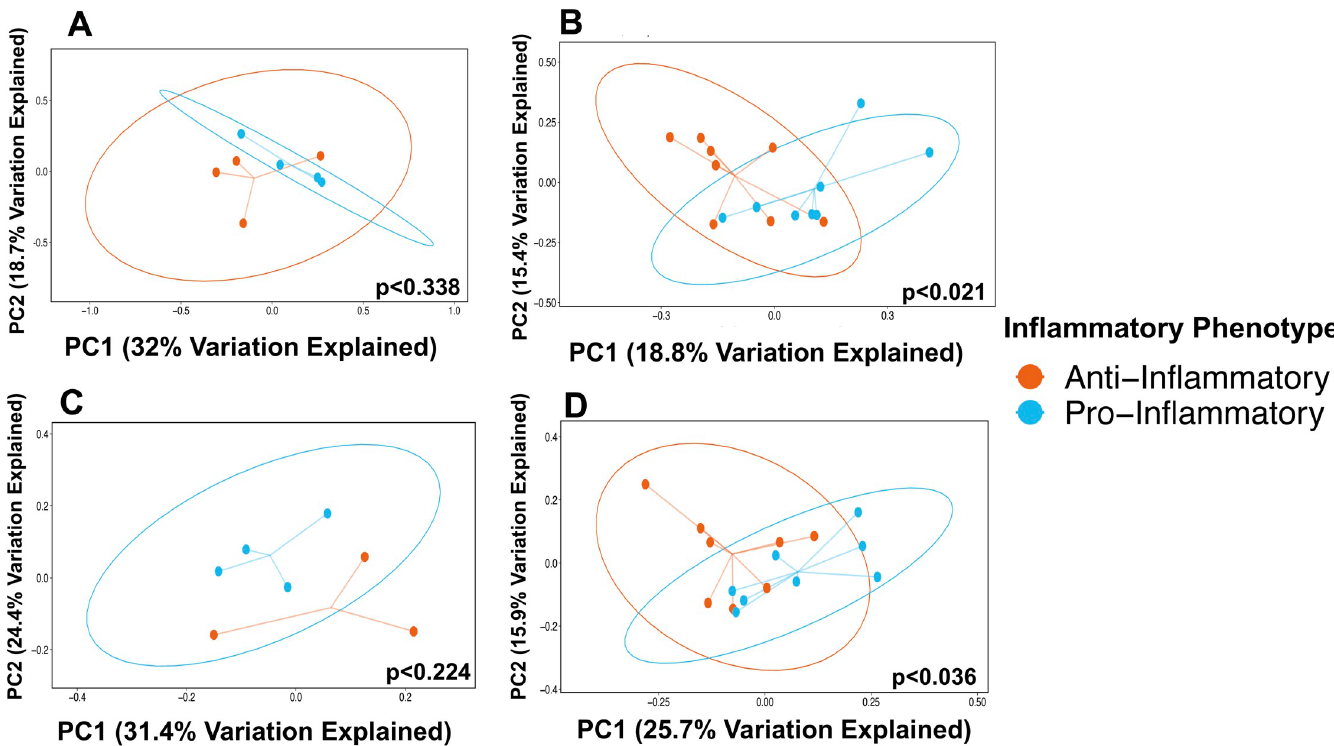
Fig 4. Principle coordinate analyses of UniFrac distances of stool and saliva Presort samples by Th17:Treg ratios in those with normoglycemia and dysglycemia. Principal coordinate analyses of unweighted UniFrac distances of stool ( A , B ) and ( C , D ) saliva Presort samples in those with ( A , C ) normoglycemia and ( B , D ) dysglycemia. P-values determined using PERMANOVA and include adjustments for body mass index.